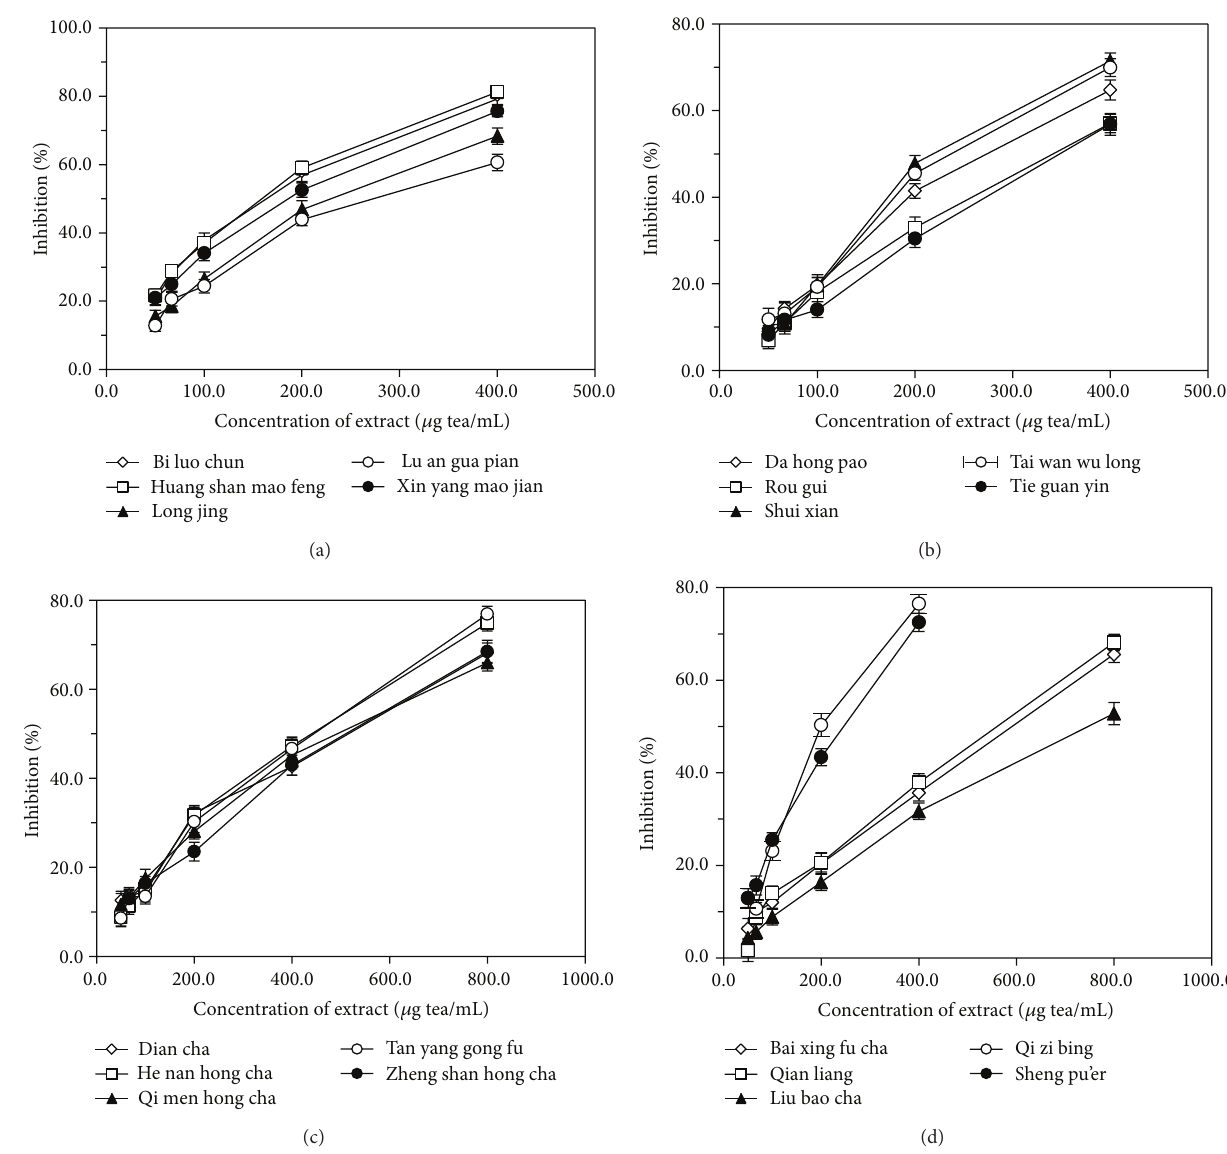
Figure 6: Percentage inhibition of DPPH radical by tea extract for green teas (a), oolong teas (b), black teas (c), and dark teas (d).